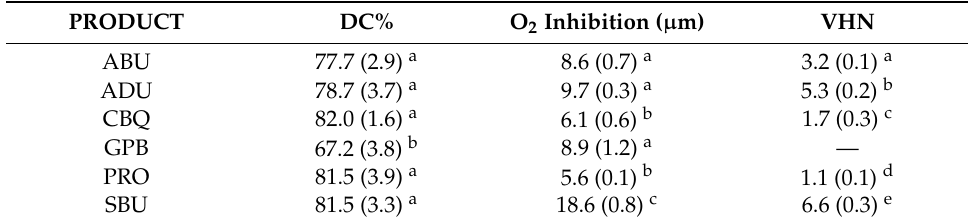
Table 2. Results of DC%, VHN and O 2 inhibition (mean values and standard deviations in parentheses). Same superscripts letters show mean values with no statistically significant differences between products per property (p > 0.05).